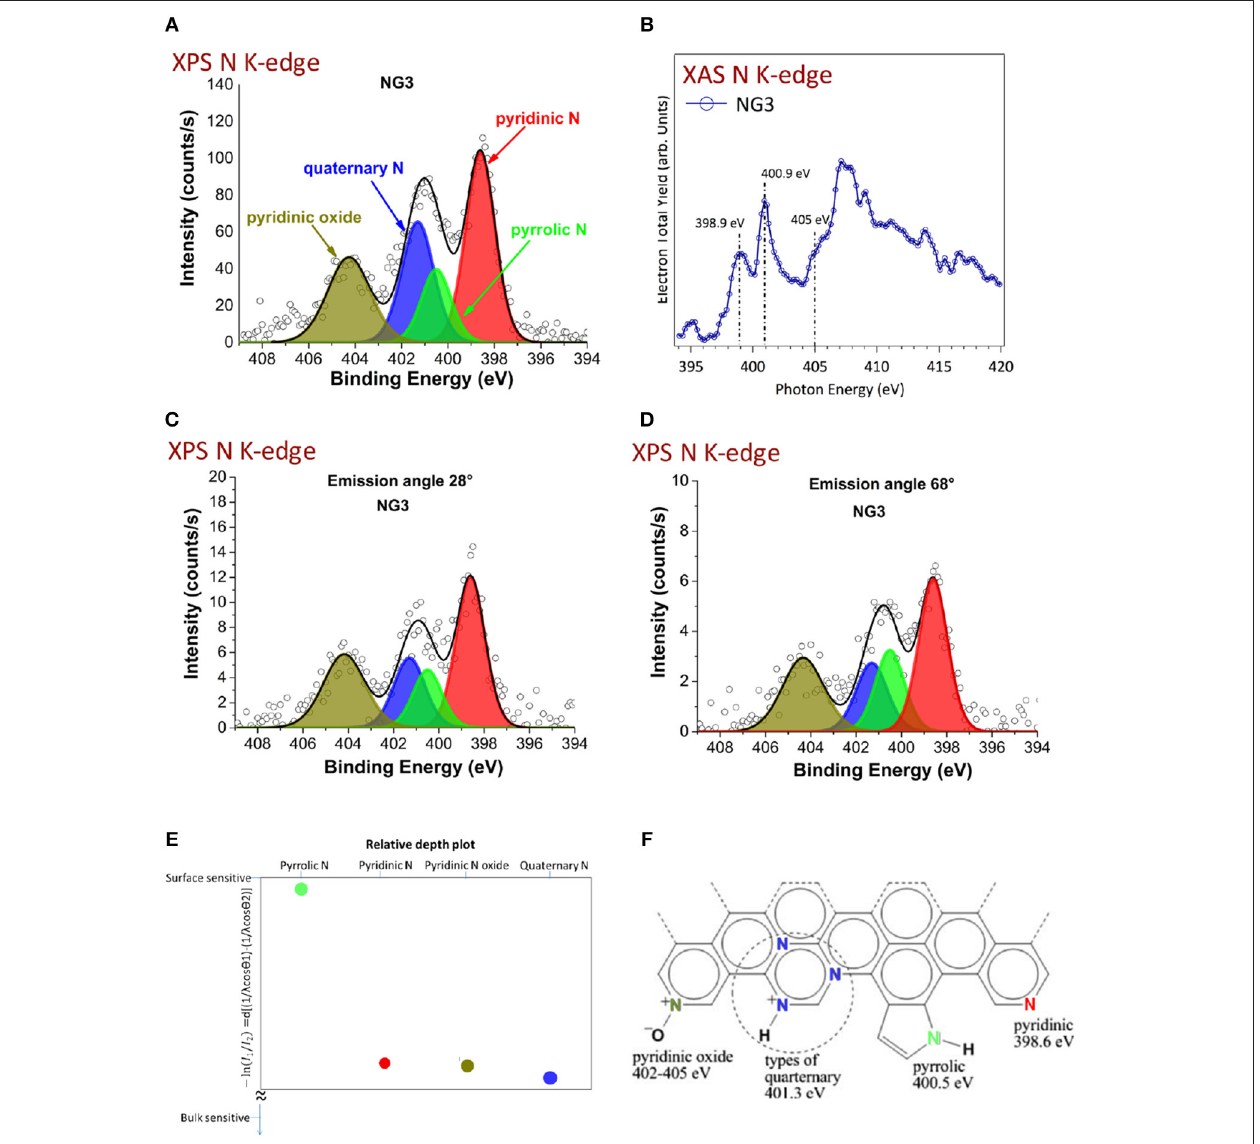
FIGURE 9 | Chemical investigation of the nitrogen chemistry of the graphene layers. (A) XPS N K-edge of N-doped graphene (2.4%N); (B) XAS N K-edge of N-doped graphene; (C,D) ARXPS N K-edge of the N-doped graphene with an emission angle of 28 and 68 ◦ ; (E) Ratio of intensity I1 (from ARXPS with 68 ◦ ) to intensity I2 (from ARXPS with 28 ◦ ) for each of the four nitrogen chemical contributions deduced from XPS, giving rise to a surface predominance of the pyrrolic from (green signal); (F) molecular scheme of the various N chemical forms identified by XPS and XAS in a N-doped graphene monolayer [Reproduced from Maddi et al. (2018) with permission of Nature Publishing